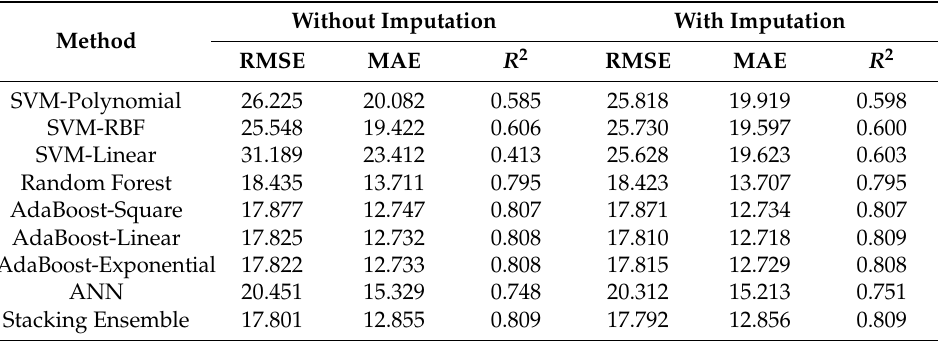
Table 8. Results of ML Algorithms for Changhua F8-AQI Prediction.